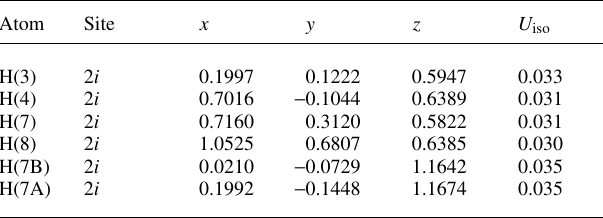
Table 2. Atomic coordinates and displacement parameters (in Å 2 )